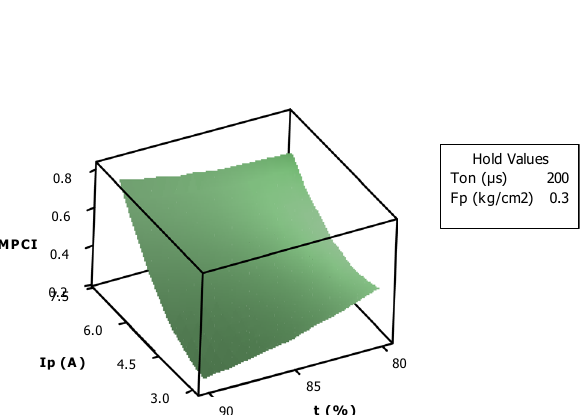
Fig. 7 Surface plot of MPCI vs I P , T on